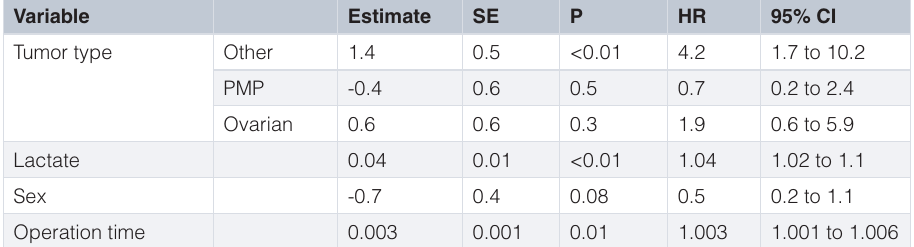
Table 10. Model predicting the logarithm of the hazard of death, after inclusion of metabolic variables (HR: Hazard ratio; SE: Standard